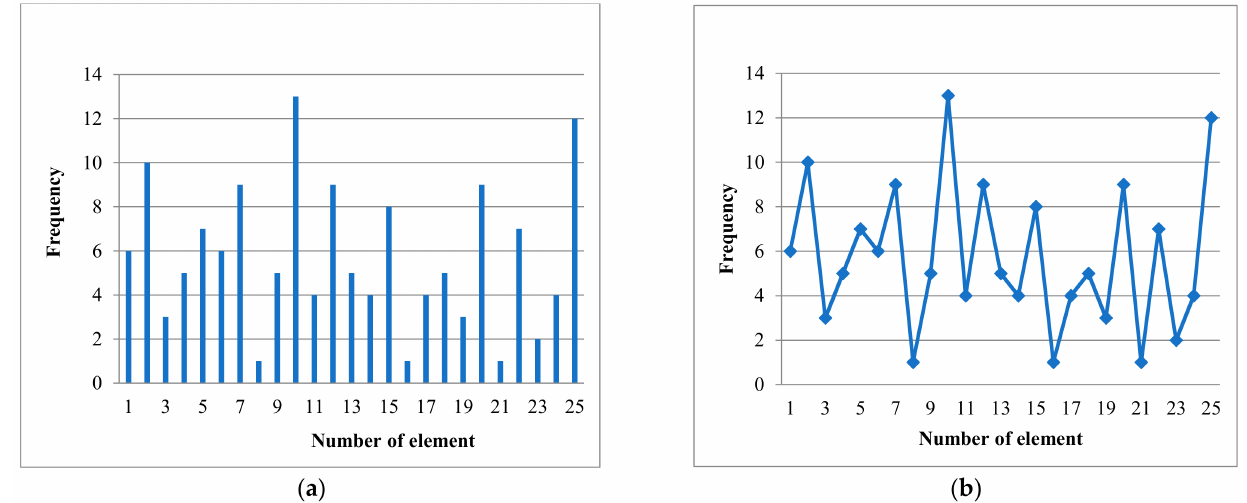
Figure 1. Types of representation of numerical sequences: chart ( a ) and chart random process ( b